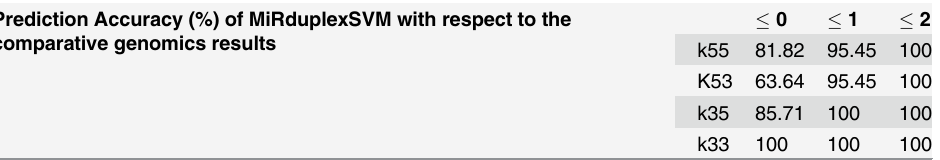
Table 3. End Absolute Error (EAE) in nts. Prediction Accuracy (%) of MiRduplexSVM with respect to the comparative genomics results